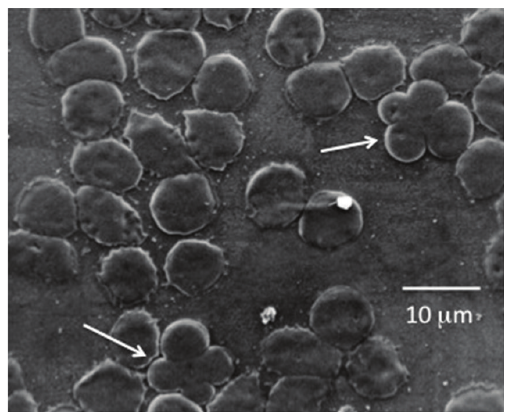
Figure 6: Two qRBCs (white arrow) in blood film at SEM (150x, 10kV).